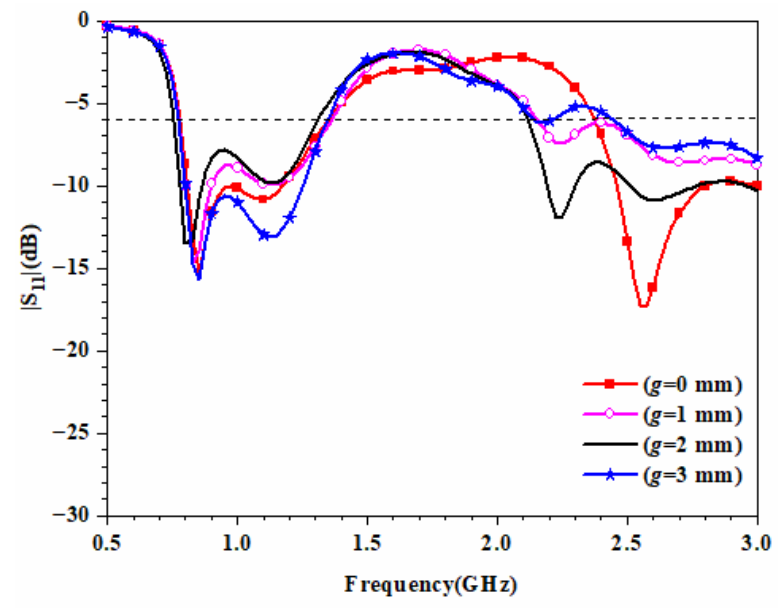
Figure 6. Influence of g on |S 11 |.